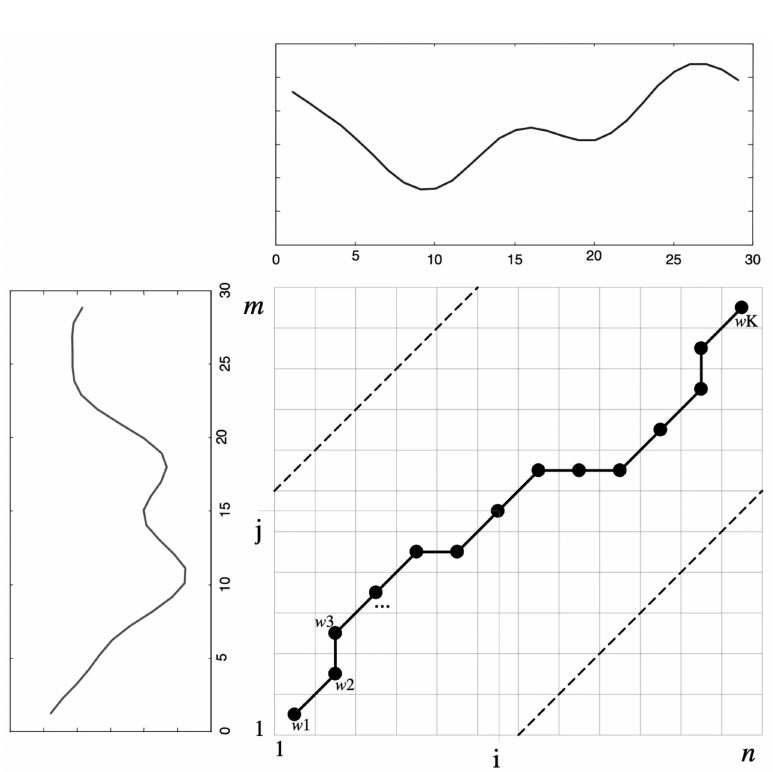
Figure 7. Example of a warping path. Source available online: https://blog.csdn.net/niyanghuahao/ article/details/78612157?locationNum=9&fps=1. (accessed on 29 December